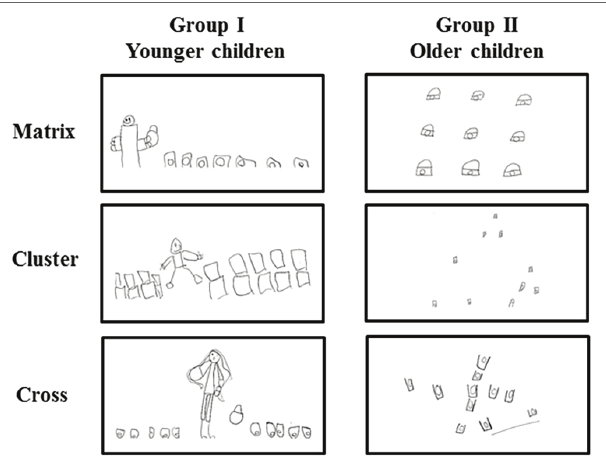
FIGURE 3 | (A) Total distance of group I and group II travelled to complete the task in Matrix, Cluster, and Cross configurations. Data are presented as mean ± SEM. (B) Trajectories traveled by all children of each group are depicted.